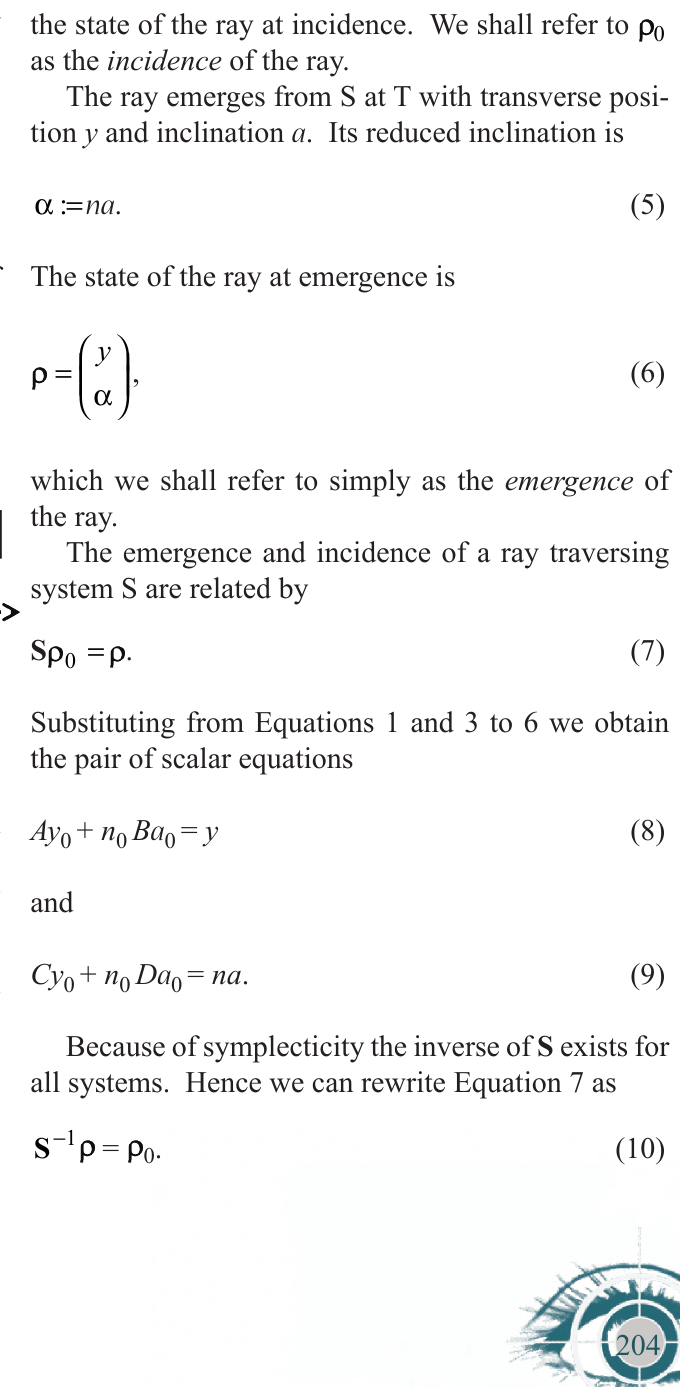
The South African Optometrist